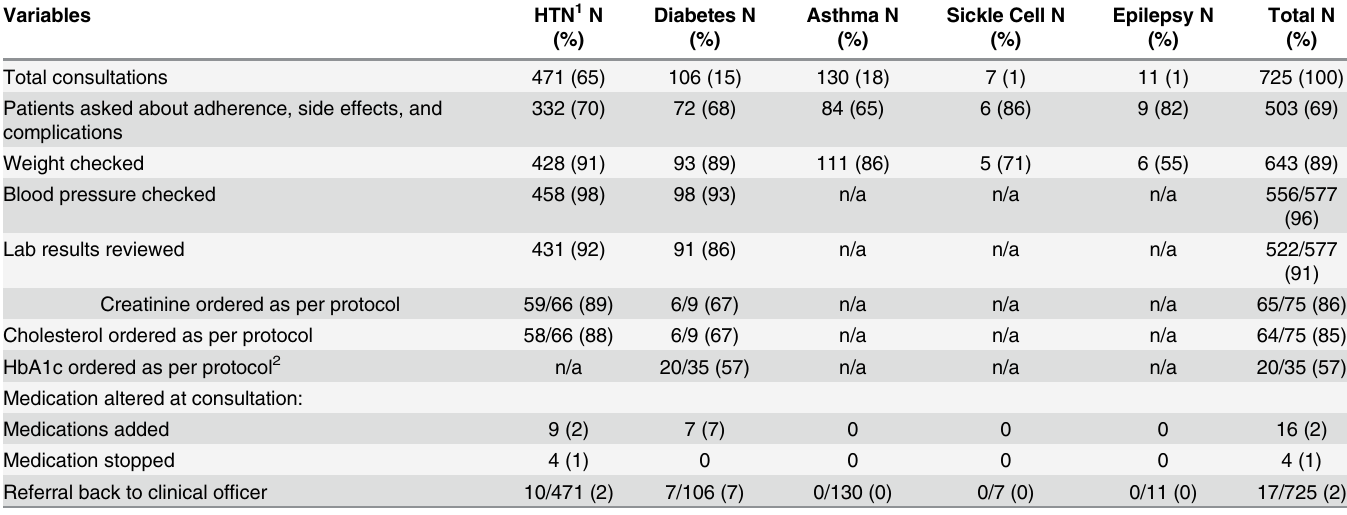
Table 2. Adherence to MSF protocols among non-communicable disease consultations by nurse clinicians in two integrated primary health care clinics in Kibera, Kenya (May-August